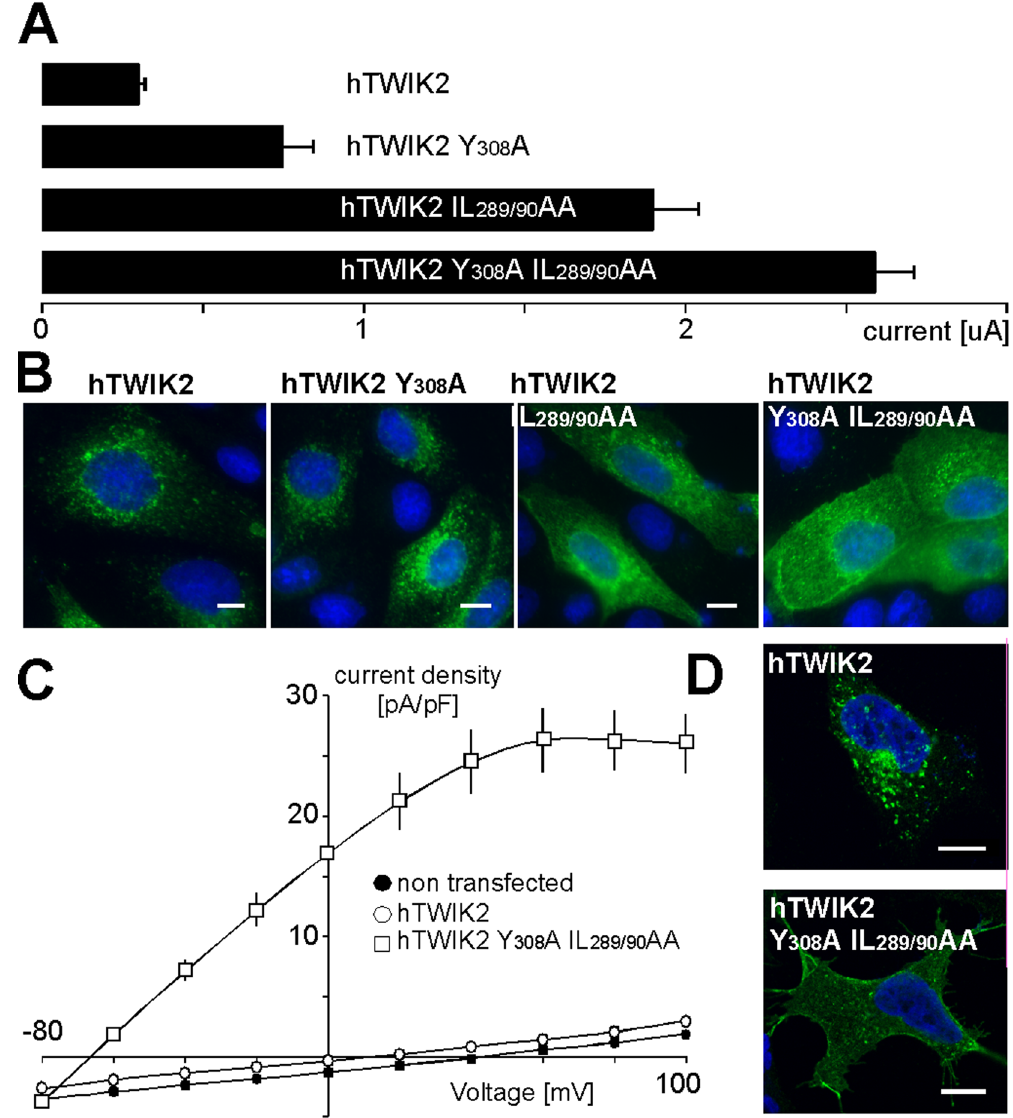
Figure 5. Human TWIK2 shows the same properties as rat TWIK2 when expressed in heterologous expression systems. Human wild type and mutated TWIK2 channels were expressed as indicated in ( A ) Xenopus oocytes (current amplitudes at + 50 mV, (number of recorded oocytes)), ( B ) MDCK cells for immunodetection with anti-HA antibody, ( C ) HEK cells for electrophysiological recordings (n = 15), and ( D ) for immunodetection with anti-HA